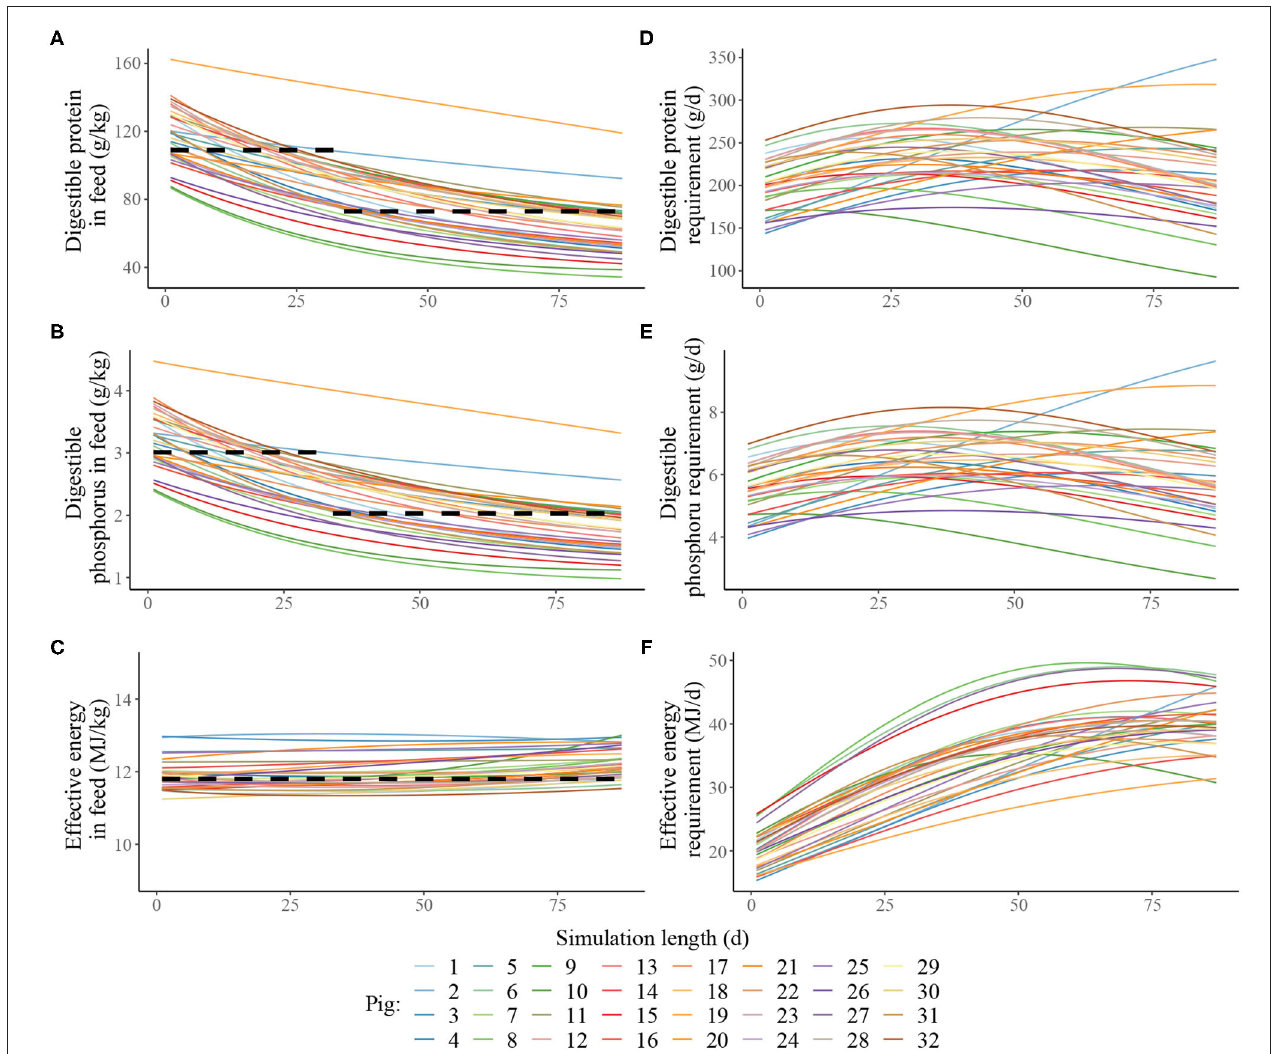
FIGURE 3 | Estimated nutritional composition of the feeds in either two-phase feeding strategy (dashed black line, Scenario 3) or precision feeding strategy (solid lines; Scenario 4) given to a pig population in terms of: (A) digestible protein (g/kg); (B) digestible phosphorus (g/kg); (C) effective energy (MJ/kg); estimated daily nutrient requirement for maintenance and growth of each of the thirty-two pigs in the population in terms of: (D) digestible protein (g/d); (E) digestible phosphorus (g/d); (F) effective energy (MJ/d). For a detailed description of the simulated scenarios, see section Simulated Feeding Scenarios.